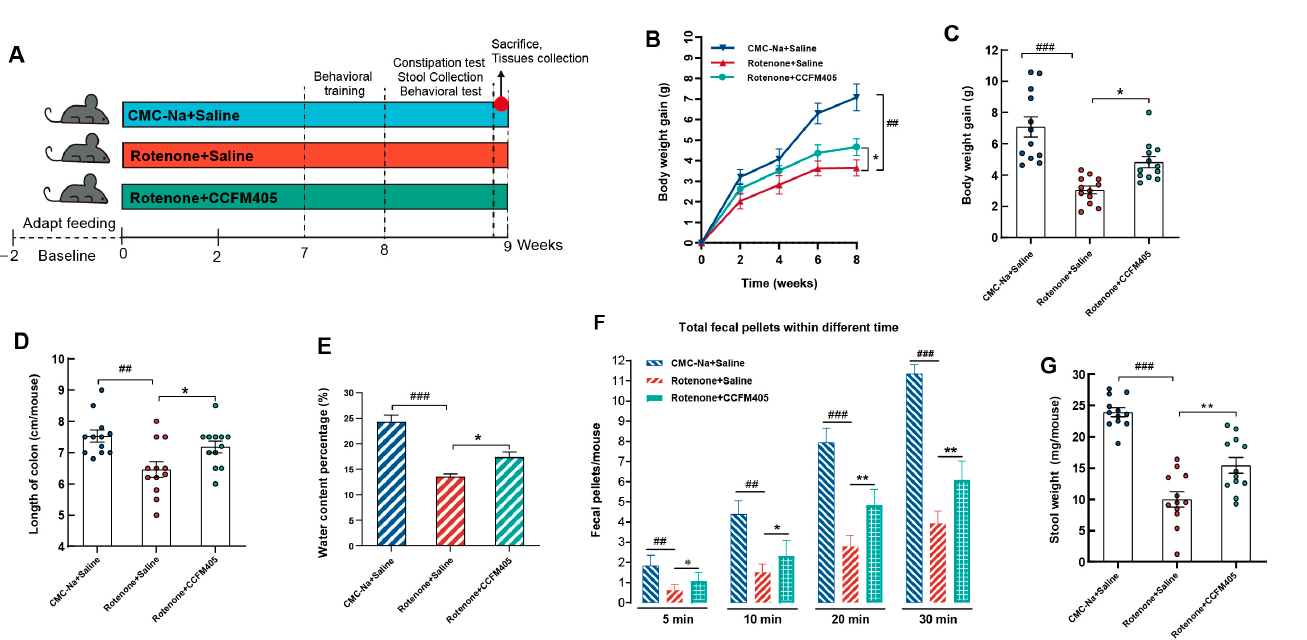
Figure 1. Effects of L. plantarum CCFM405 on body weight and gastrointestinal function in rotenone- induced PD mice. ( A ) Timeline of experimental design; ( B ) changes in body weight during feeding; ( C ) weight gain at the endpoint; ( D ) colon length of mice; ( E ) fecal water content of mice at the intervention endpoint; ( F ) number of mice defecation grains at different periods; ( G ) fecal weight of mice at the intervention endpoint. n = 12/group. Data are means with SEM. ## p < 0.01, ### p < 0.001